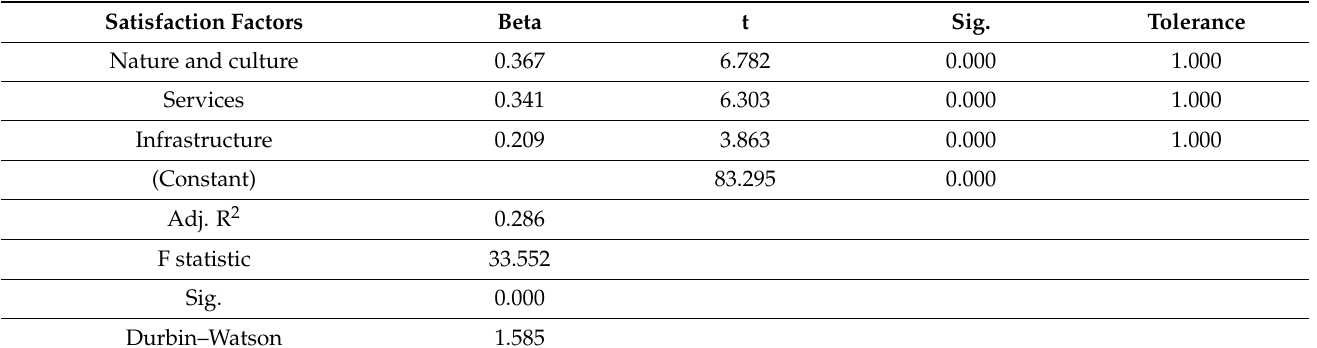
Table 3. Relationship of satisfaction factors with the intentions to recommend the destination (Multiple